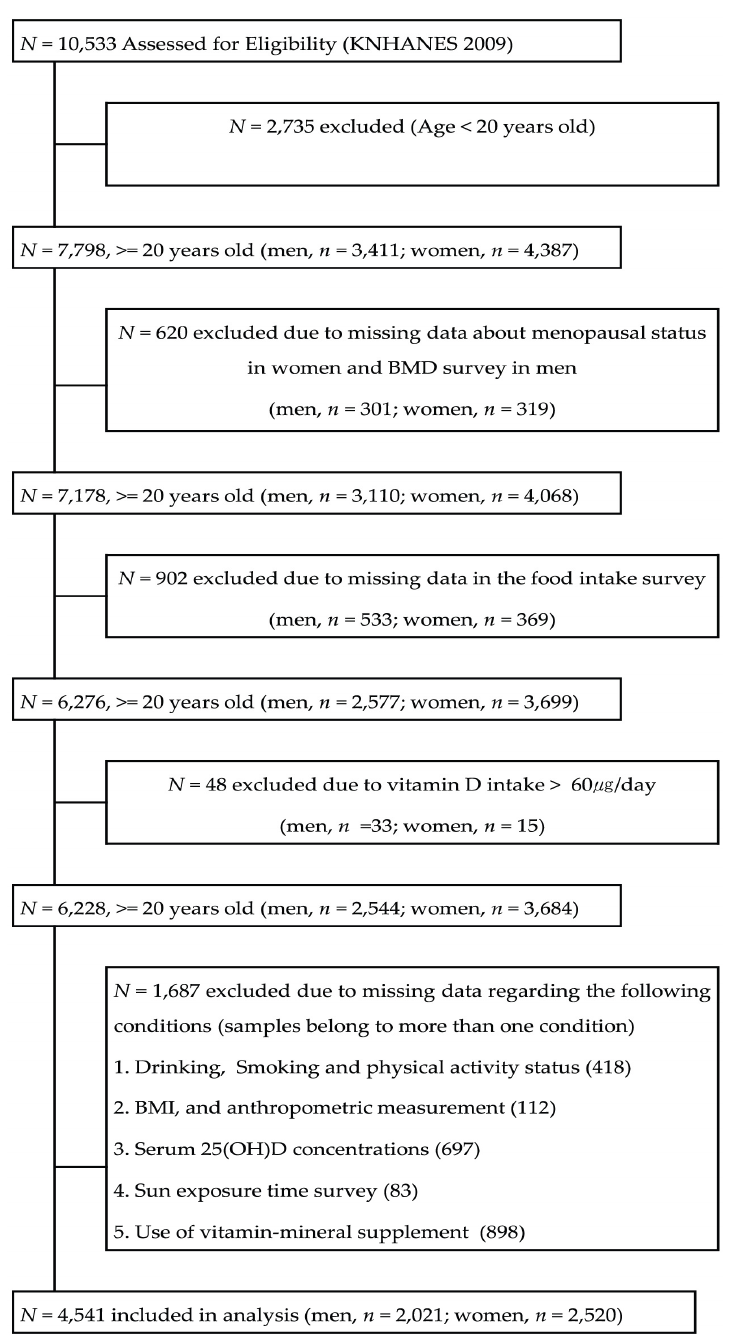
Figure 1. Flowchart of subject inclusion and exclusion in the Korea National Health and Nutrition Examination Surveys 2009 (BMD, bone mineral density; BMI, body mass index; 25(OH)D, 25-hydroxyvitamin D).